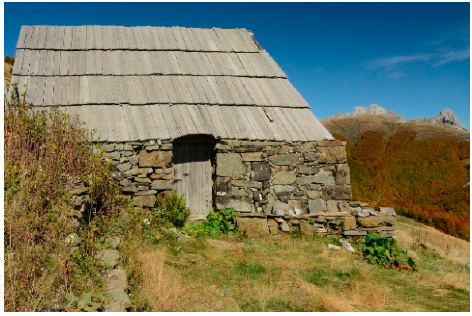
Figure 19. Construction of limestone, photo: I. Lakovi ć .